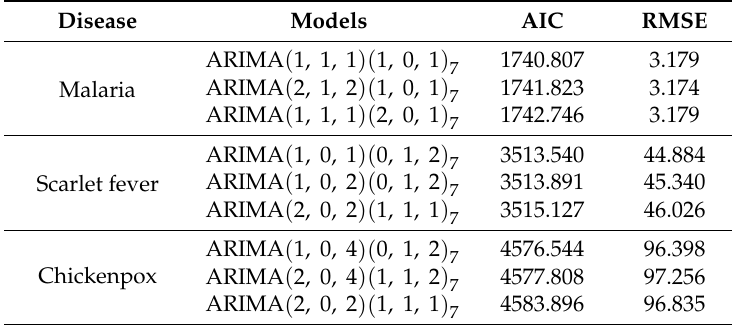
Table 4. Results of seasonal ARIMA. AIC: Akaike information criterion; RMSE: root mean squared